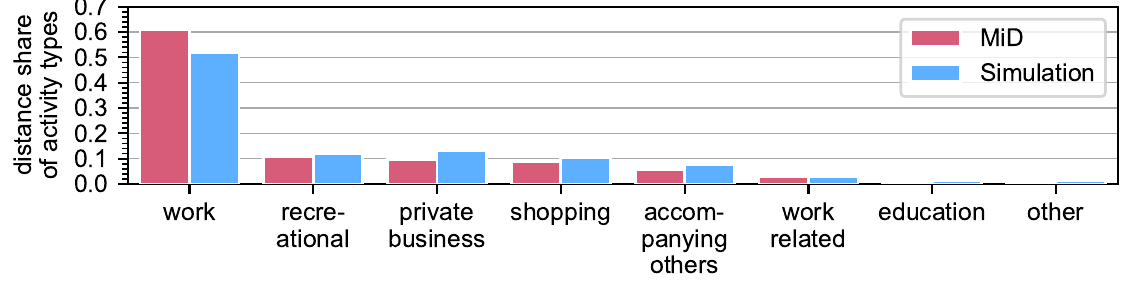
Figure 12. Distance share among activity types. Comparison of simulation and